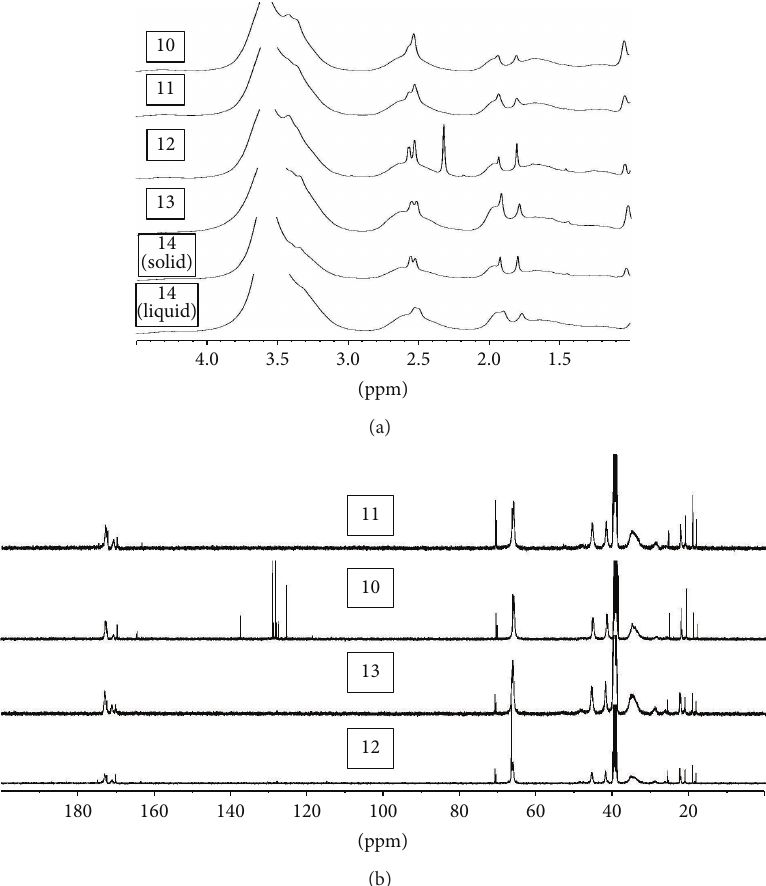
Figure 5: NMR spectra (solvent DMSO) for poly(NMNVA) synthesized in different solvents: 10 in methanol, 11 in 1,4-dioxane, 12 in THF, 13 in toluene, and 14 in diphenyl ether (solid and liquid phase): (a) 1 H-NMR; (b) 13